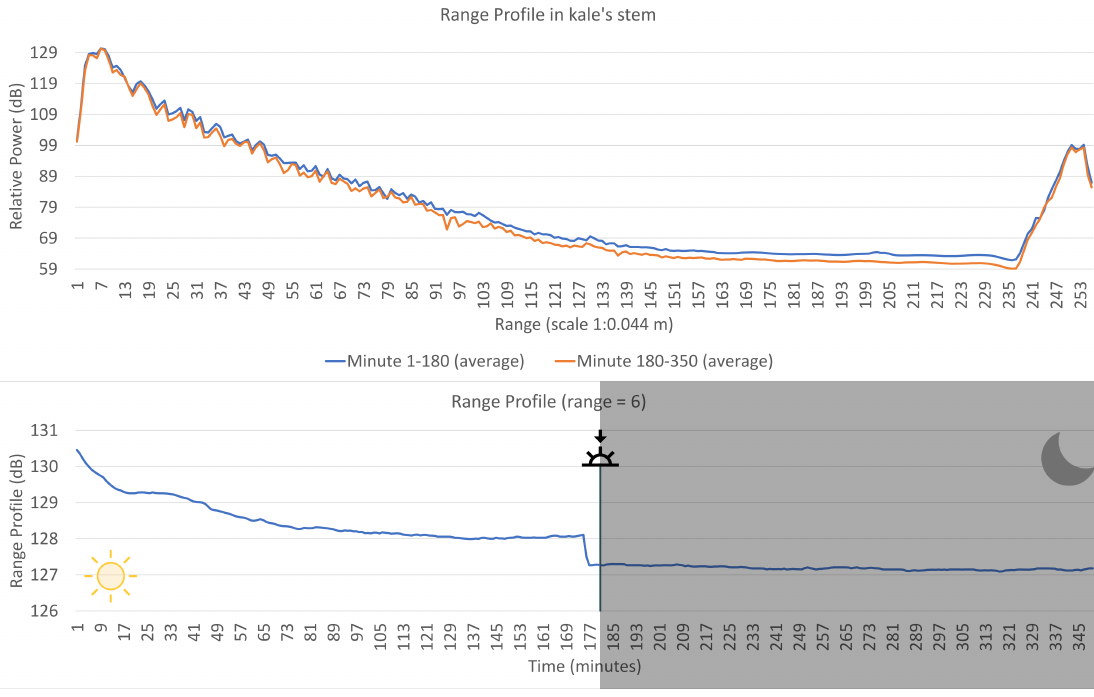
Figure 15. Result of the second test with kale’s stem during the day/night transition; vertical line: